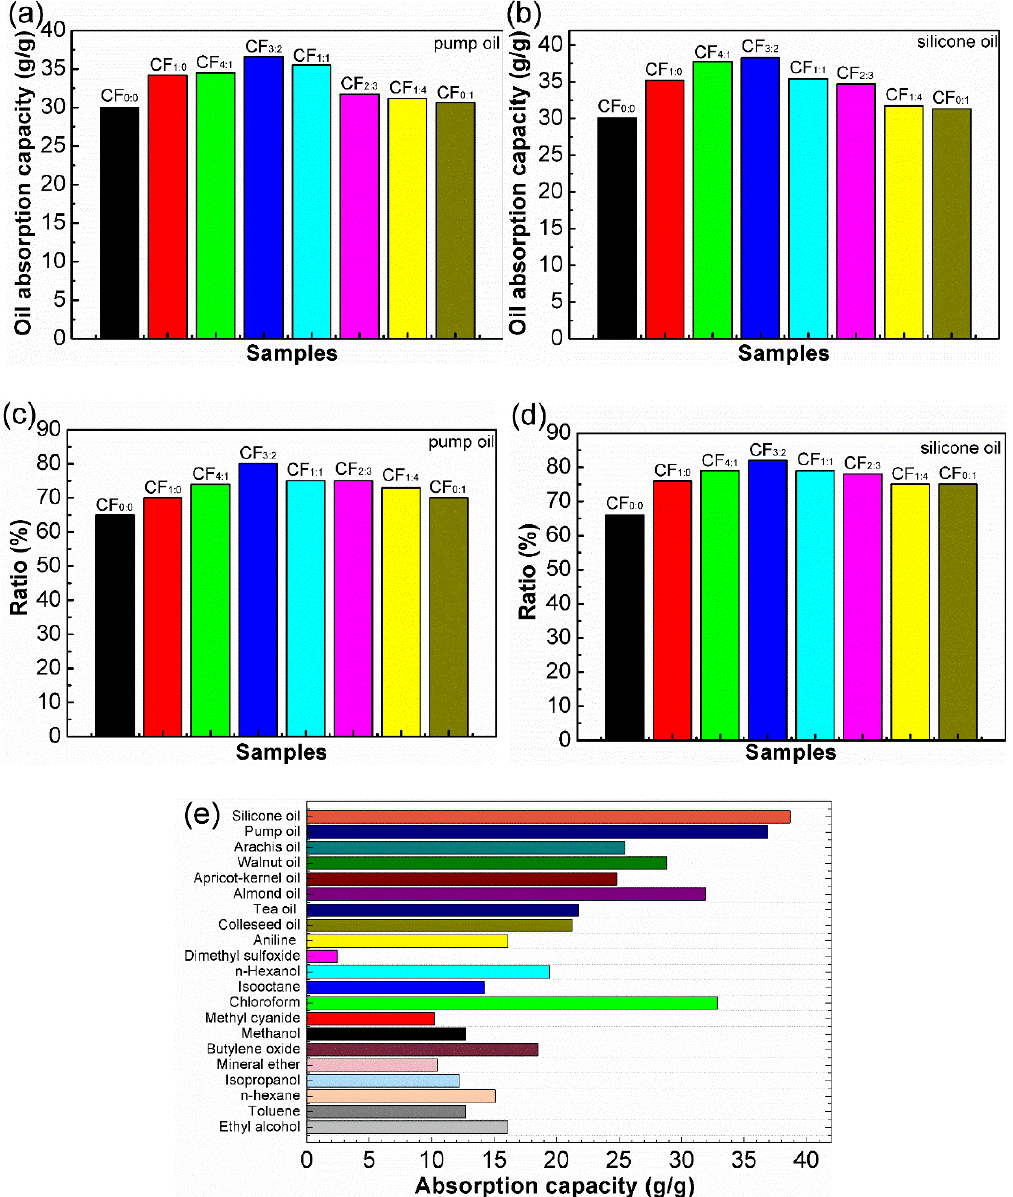
Figure 9. Absorption capacities of unmodified and modified CF ( a , b ), 10 times usage ( c , d ) and CF 3:2 for various oils, organic solvents (e).